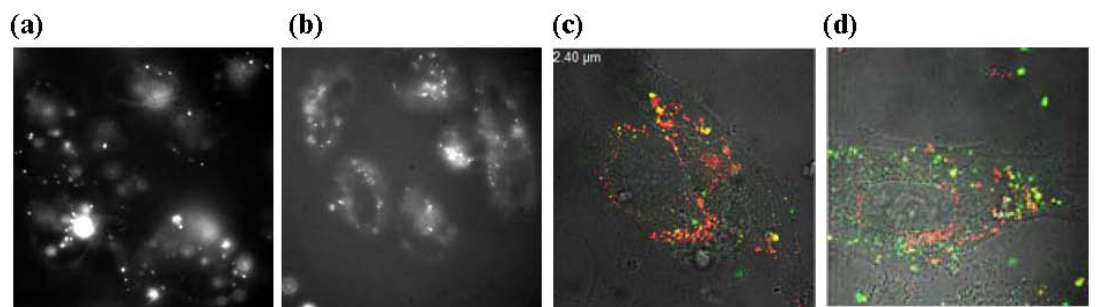
Figure 6. ( a ) Aggregates of rhodamine labeled DNA in cationic lipoplexes at the membrane and internalized by CHO cells in suspension 24 h after incubation; ( b ) Thiourea rhodamine labeled DNA lipoplexes (DDSTU, lipid 3 ) internalized as punctuates by CHO cells in suspension 24 h after incubation; ( c ) Cationic lipoplexes labeled with rhodamine (red) and fluorescent DNA (green) internalized by HeLa cells after a 30 minute incubation at 37 °C; ( d ) Thiourea lipoplexes labeled with rhodamine (red) and fluorescent DNA (green) internalized by HeLa cells after a 30 minute incubation at 37 °C.